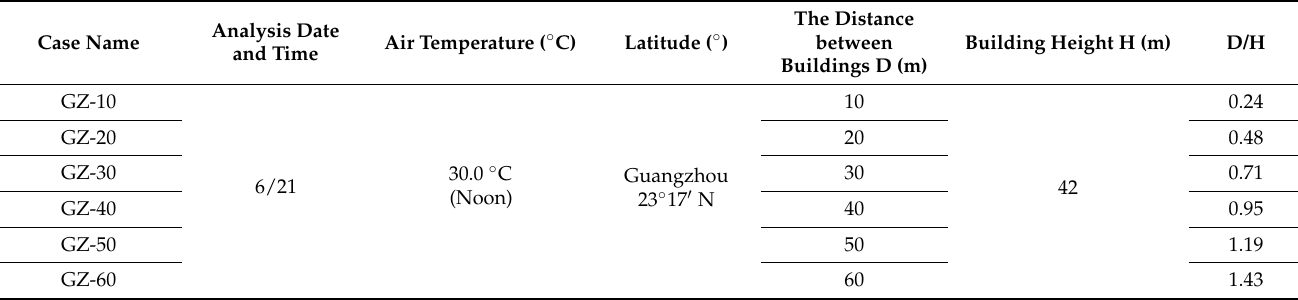
Table 3. Analysis